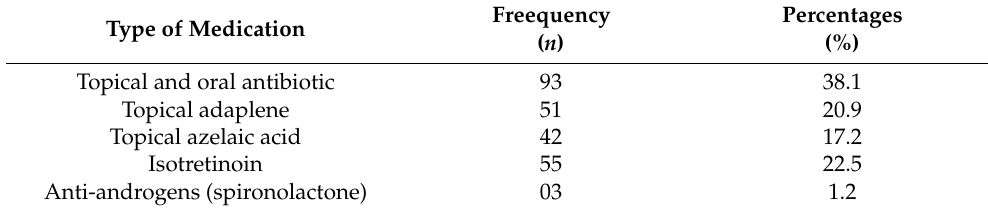
Table 3. Type of medication ( n = 244).